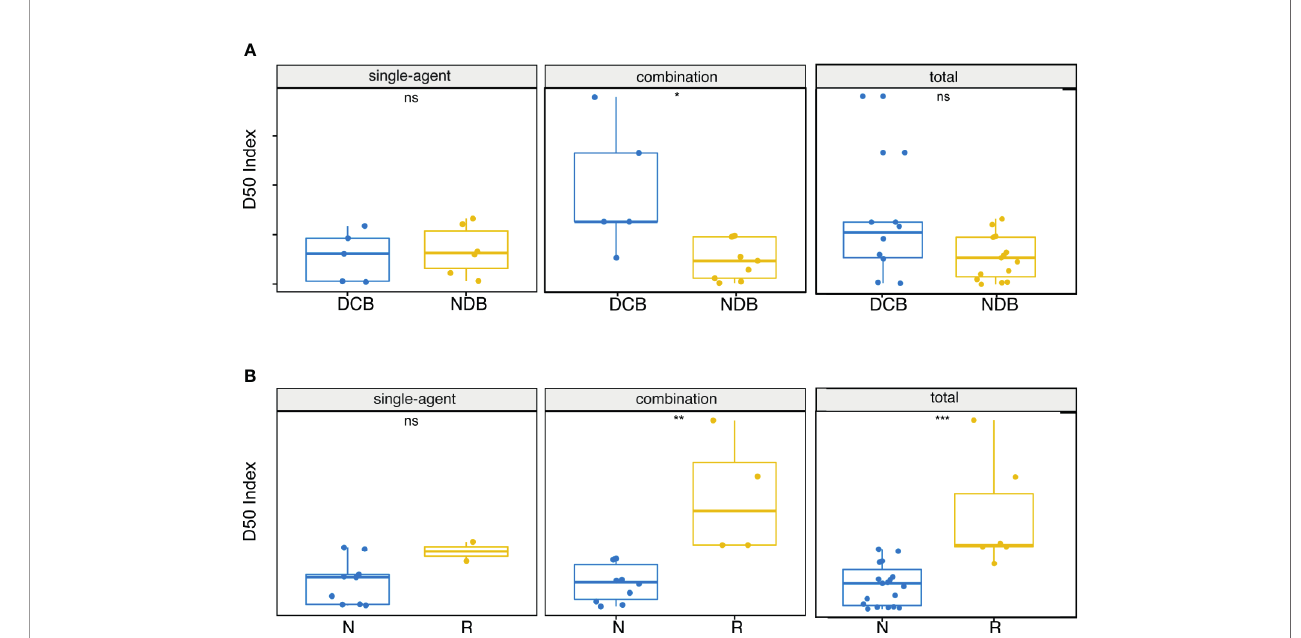
FIGURE 2 | Correlations between D50 index and clinical bene fi t. (A) Correlations between D50 index and durable clinical bene fi t at post-treatment samples. (B) Correlations between D50 index and response at post-treatment samples. Statistical analysis was performed using the Mann-Whitney test. Boxes depict the interquartile range with the line in boxes showing the median, and the lines outside the boxes showing the fi rst or third quartiles of fraction. ns p >= 0.05, *p < 0.05, **p < 0.01, ***p <